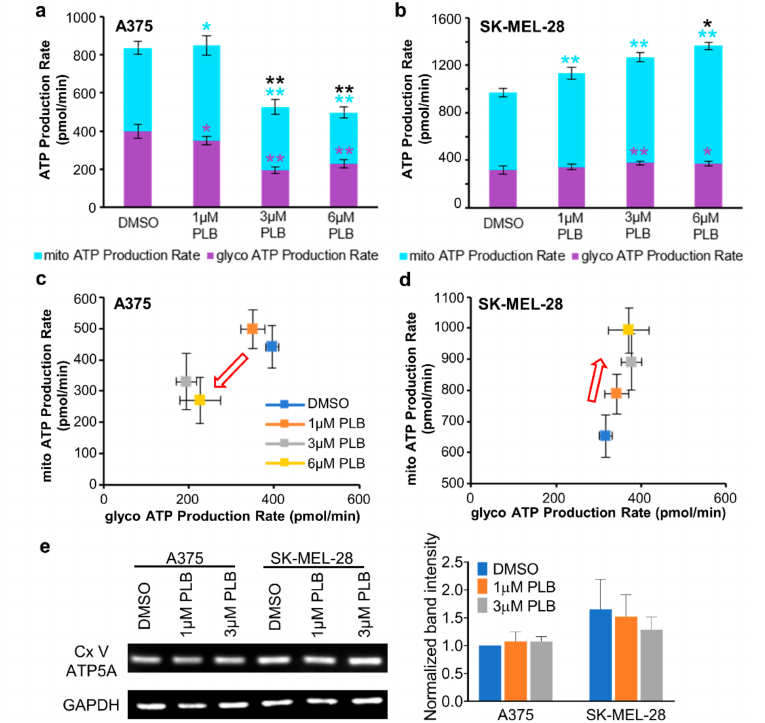
Figure 6. PLB induced alternations of ATP production. Melanoma cells were seeded in the seahorse XF96 cell culture microplates at the density of 2 × 104. DMSO and 1, 3, and 6 µ M PLB were acutely applied in the Seahorse machine with the following injection of Oligo, ROT, and AA ( n = 3–8). ( a ) The bar figure shows the absolute value of ATP production contributed by mitochondria and glycolysis in A375 cells. The significance for each experimental group was compared with the DMSO group. Asterisks in black, purple, and light blue represent total glycolysis and mitochondrial ATP production. ( b ) The bar figure shows the absolute value of ATP production contributed by mitochondria and glycolysis in SK-MEL-28 cells. The significance for each experimental group was compared with the DMSO group. Asterisks in black, purple, and light blue represent total glycolysis and mitochondrial ATP production. ( c ) ATP production map in A375 cells. The red arrow represents the trend of ATP production with the increasing concentrations of PLB. ( d ) ATP production map in SK-MEL-28 cells. The red arrow represents the trend of ATP production with the increasing concentrations of PLB. ( e ) Western blot result shows the expression of ATP5A, a subunit of mitochondrial Cx V in two cell lines with DMSO and 1 and 3 µ M PLB treatment. The bar figure displays the normalized results compared with the expression of GAPDH ( n = 3). Results are expressed as mean ± SD. * p < 0.05, ** p < 0.01. ATP5A, ATP synthase subunit alpha; Cx V, complex